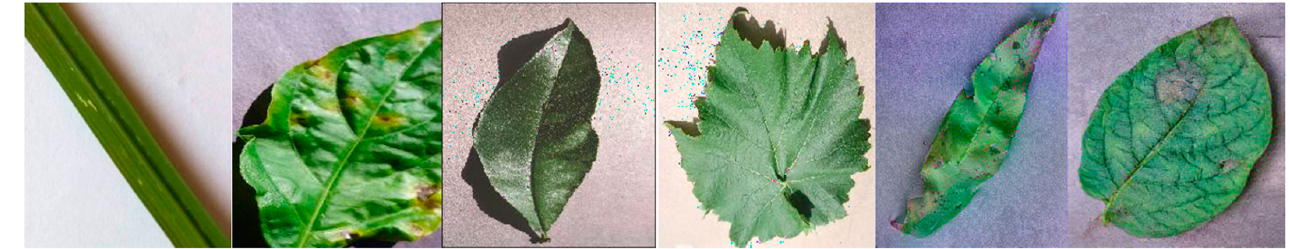
Figure 1. Sample augmented images using BIM, DCGAN and NST techniques.